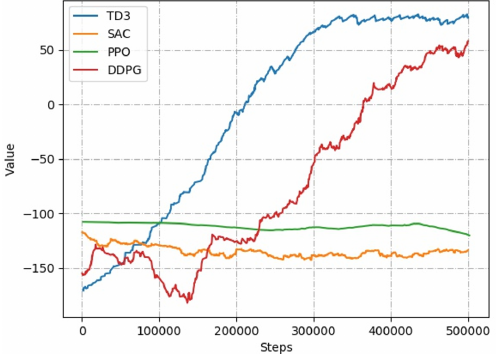
Figure 6. The convergence evaluation on RL